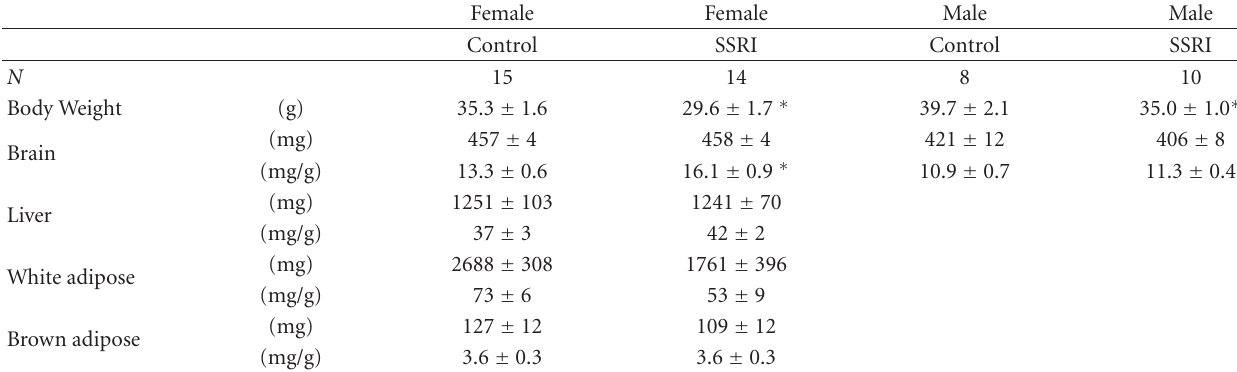
Figure 2: Neonatal SSRI exposure increases adult caloric intake. Intake of standard rodent chow was recorded over a 2 week interval and compared between control mice that received 10mL/kg/d saline (white bars) and SSRI-exposed mice that received 5mg/kg/d sertraline (gray bars) from P1 to P14. N = 27 control female (16 litters), 24 SSRI-exposed female (14 litters), 14 control male (9 litters), 12 SSRI-exposed male (10 litters); ∗ P = 0 . 004 versus control by ANOVA. Table 1: From postnatal day 1 to 14, mice received injections of saline (control) or the SSRI sertraline. After obtaining adult phenotypes, tissue weights were obtained from 11- to 12-month-old female and 6- to 9-month-old male mice. ∗ P < 0 . 05 versus control by Student’s t